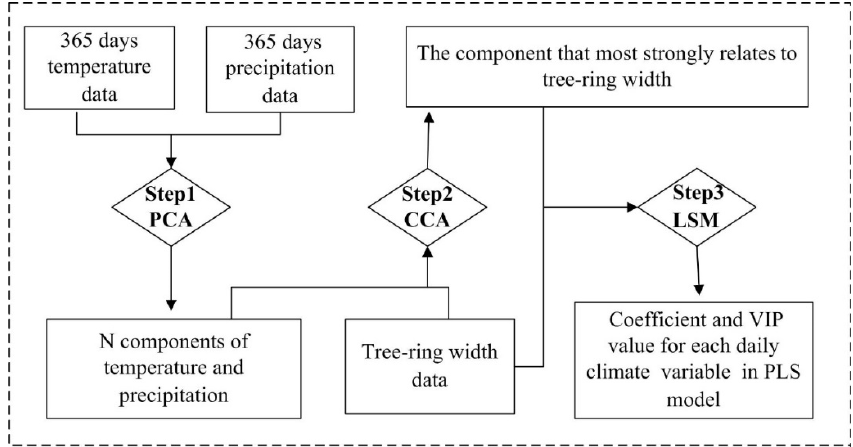
Figure 3. Framework of implementing Partial Least Square Regression (PLS) based on daily temperature and precipitation data and tree-ring widths of pine trees. N = total number of observations. PCA (principal component analysis) is used to remove the collinearity among daily temperature and precipitation data. CCA (canonical correlation analysis) was used to find the components that most strongly relate to tree-ring width. LSM (least squares method) was used for parameter estimation in the PLS model. VIP (variable importance in the projection) was used to judge the importance of each variable.